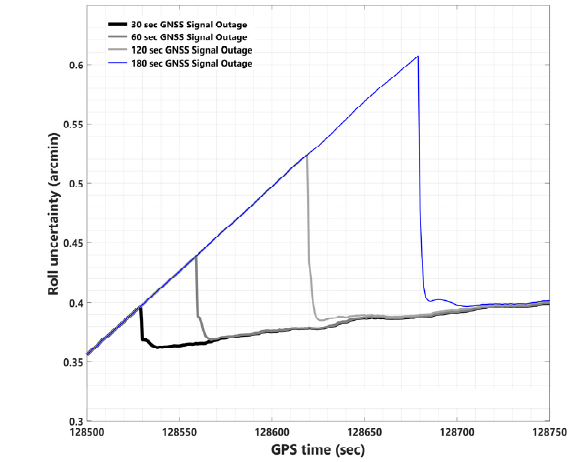
Figure 8. Uncertainties of the roll angle using smooth processing and assuming different GNSS signal